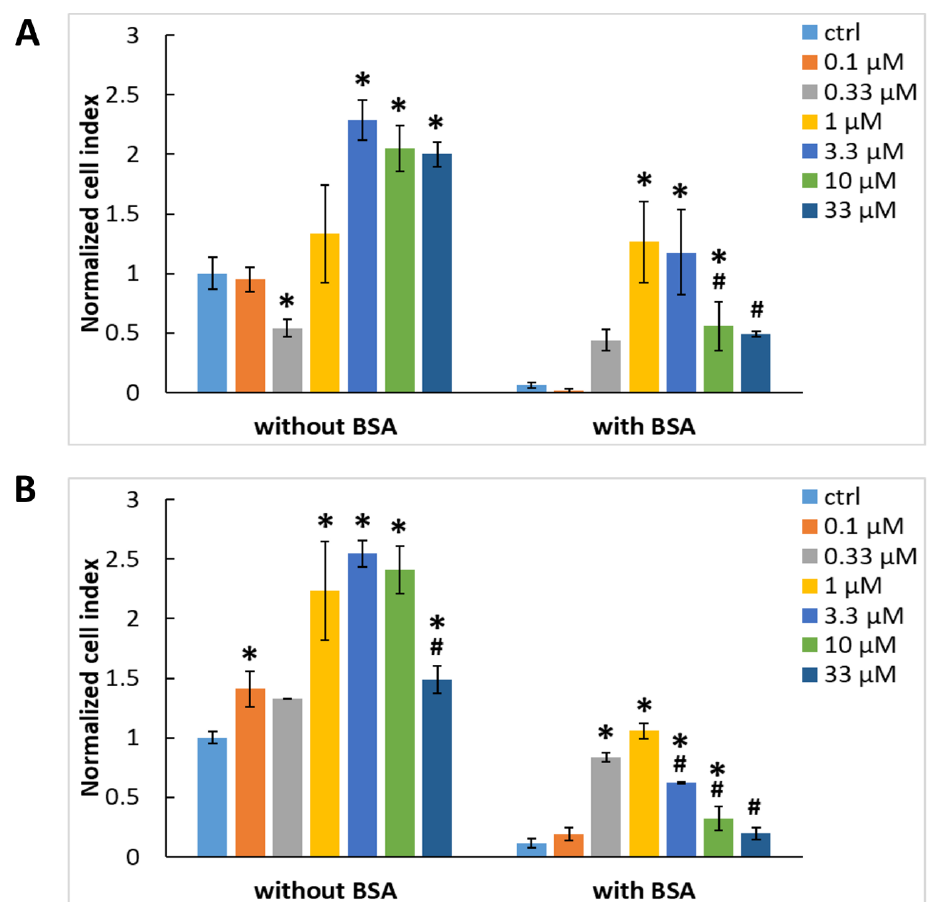
Figure 5. Initial adhesion of ADSCs ( A ) and HUVECs ( B ) to the wells of the E-plates in the xCELLigence system 1 h after seeding. The wells were adsorbed with various concentrations of Gal-3 (0.1–33 μM) either without blocking or with blocking using 0.5% w/v BSA. Cell index values were normalized to the control cell sample without adsorbed Gal-3 and BSA (ctrl without BSA). Mean ± SD ( n = 3). Holm-Sidak test, p ≤ 0.05. The cell samples were statistically compared either within the group without BSA or within the group with BSA. * Statistically significant difference in comparison with the control samples without adsorbed Gal-3 (ctrl). # Statistically significant difference in comparison with the sample exhibiting the highest average value of the cell index.